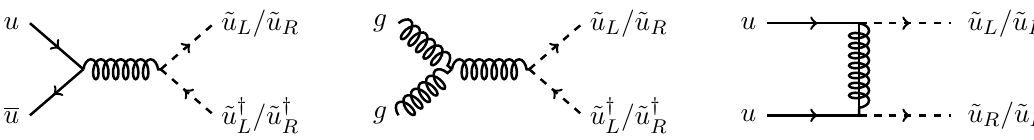
pairs to be produced. For simplicity, only one R